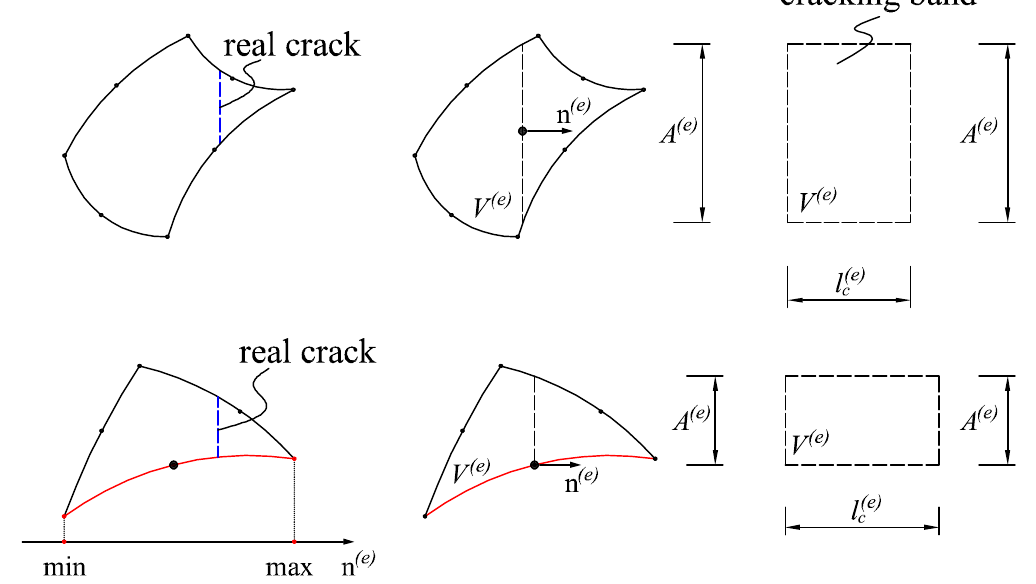
Figure 2. Relationships between l c , V ( e ) and A ( e ) of Q8 and